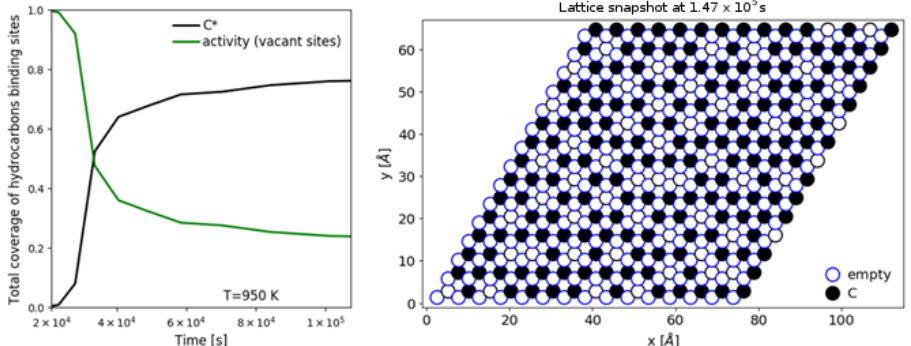
Figure 13. ( Left ) Temporal evolution of the lattice coverage. ( Right ) Lattice snapshot at the final time of the kMC simulation. Please note that there are two types of active sites on the lattice, corresponding to the binding sites for hydrocarbons (black) and hydrogen (blue). The simulation conditions are P = 1 bar and T = 950 K. (Reprinted with permission from [20]).